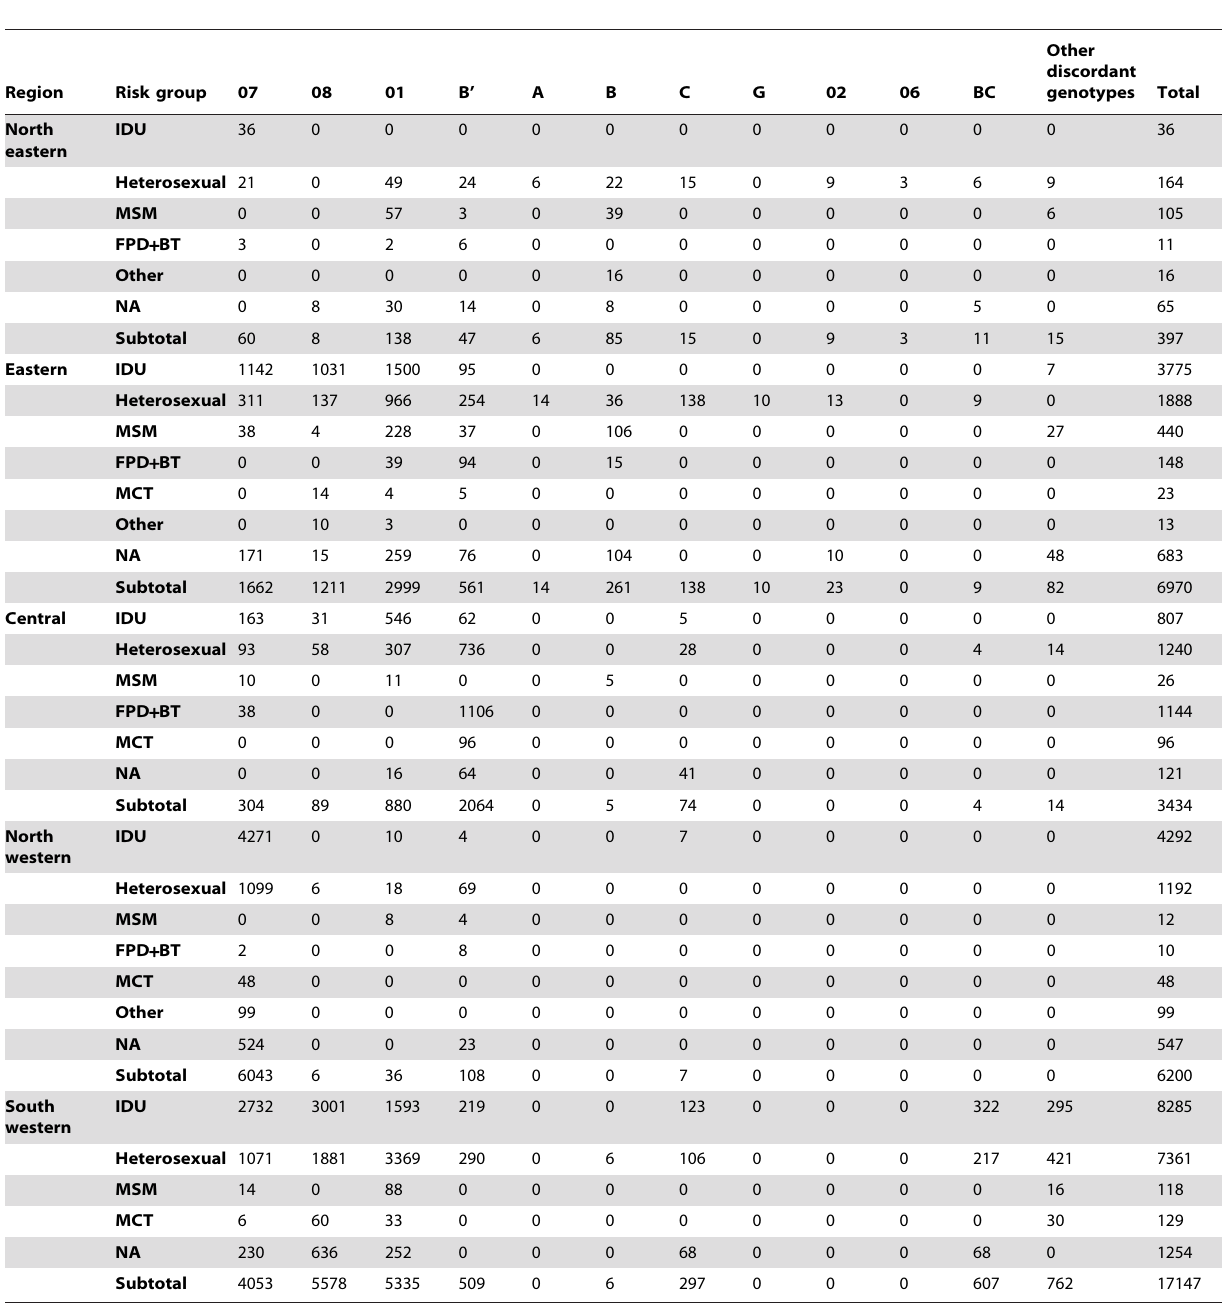
Table 3. Estimated distribution of HIV-1 genotypes in different risk groups and regions in